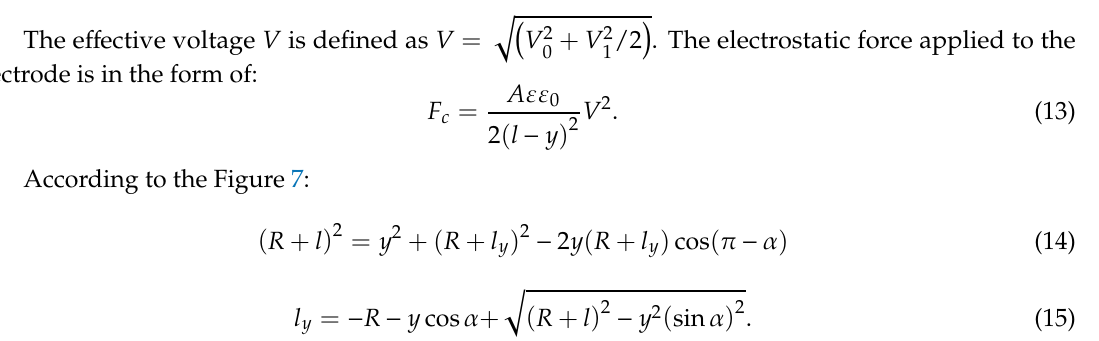
Figure 7. Schematic diagram of the force model of a rigid